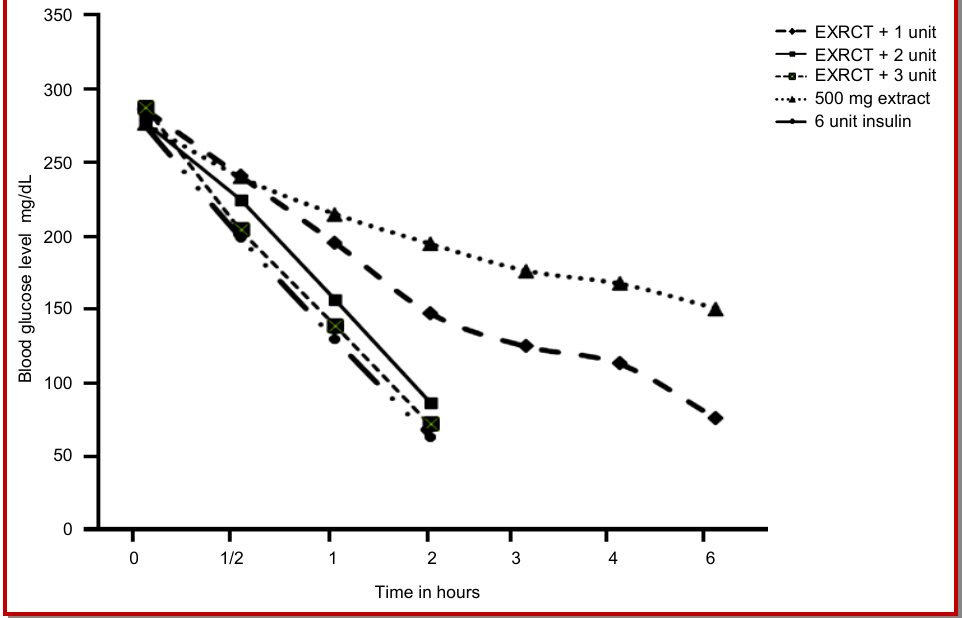
Figure 5: Hypoglycemic activity of ethyl acetate extract of Teucrium stocksianum with and without different units of insulin in diabetic rabbits